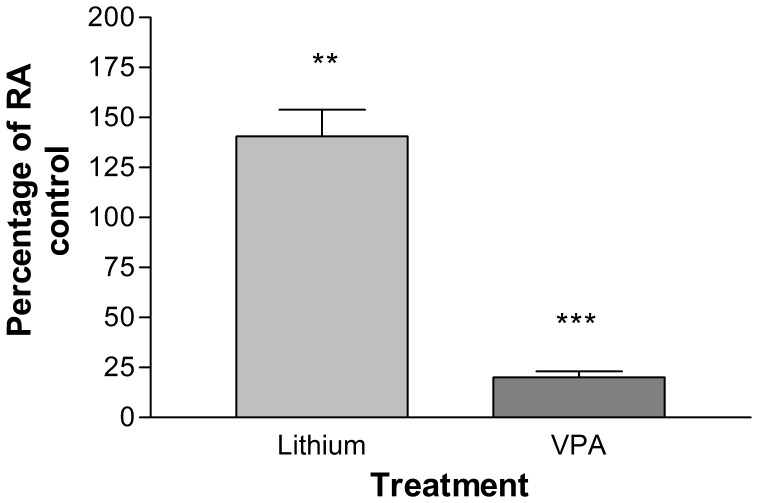
Total number of cells from dissociated neurospheres following treatment with VPA+RA and LiCl+RA as a percentage of the RA treated control.Cell populations of dissociated neurospheres post treatment with VPA (0.5 mM) and LiCl (1.0 mM). Results are shown as ± S.E.M (n = 3). p<0.05(*), p<0.01(**), p<0.001(***). p values were calculated by One-way ANOVA and corrected for multiple comparisons by Dunnets’s post-test in comparison to the RA only control.